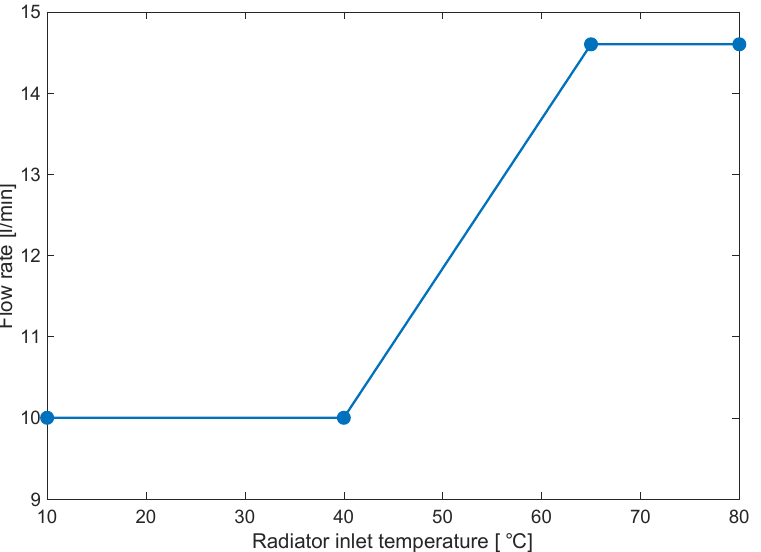
Figure 11. Pump conventional control strategy: linear dependence of mass flow rate on coolant temperature at radiator inlet.